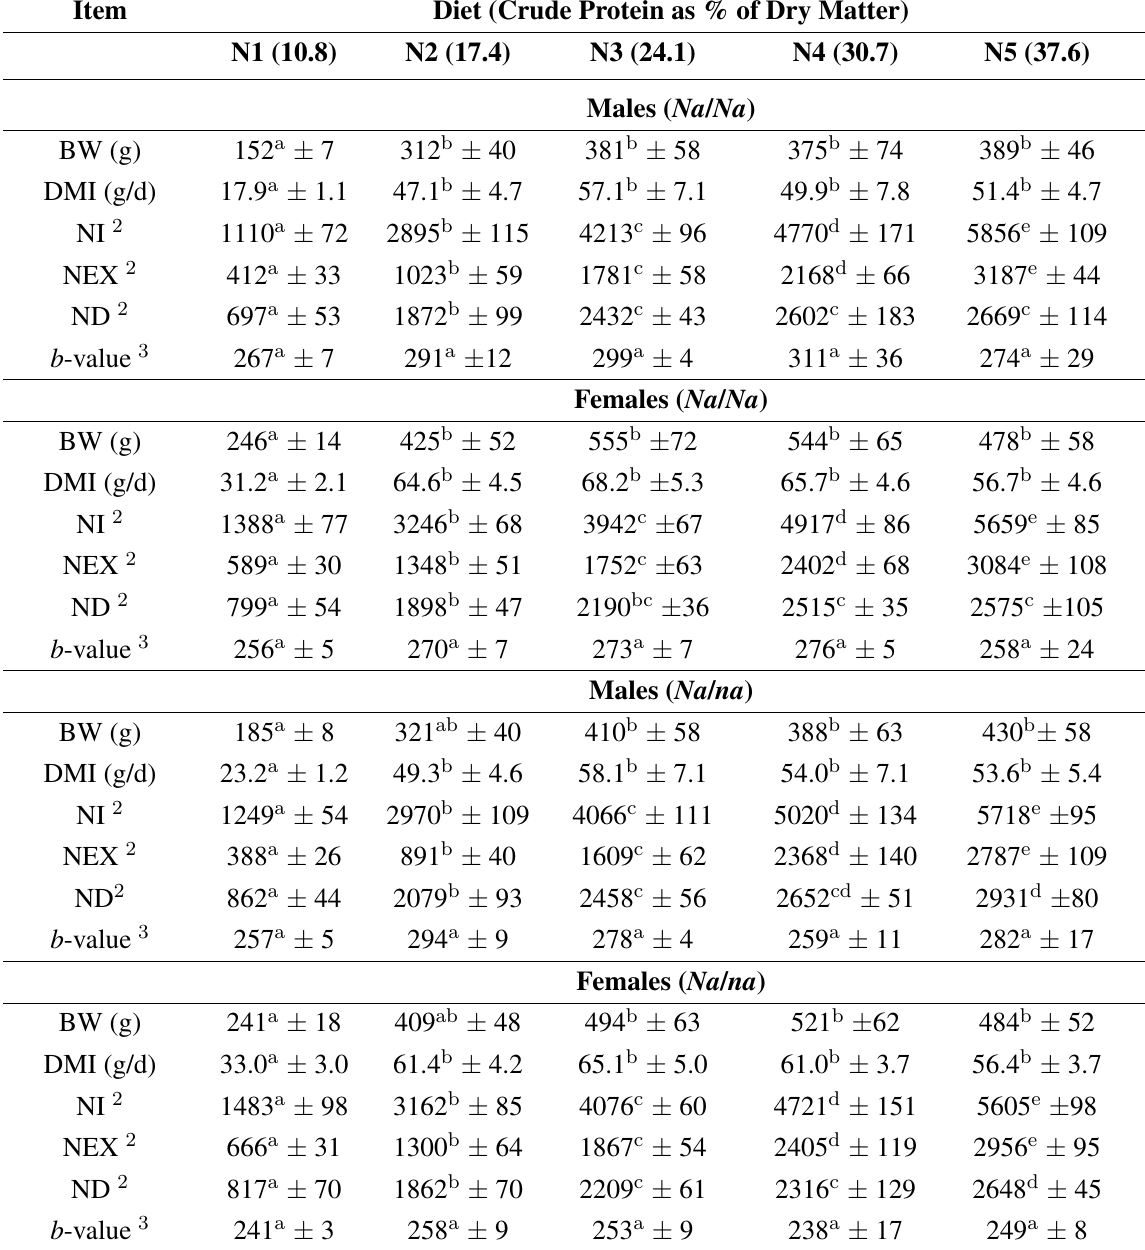
Table 4. Results of N balance experiments depending on dietary protein content, genotype and sex during starter period (days 10–20) 1